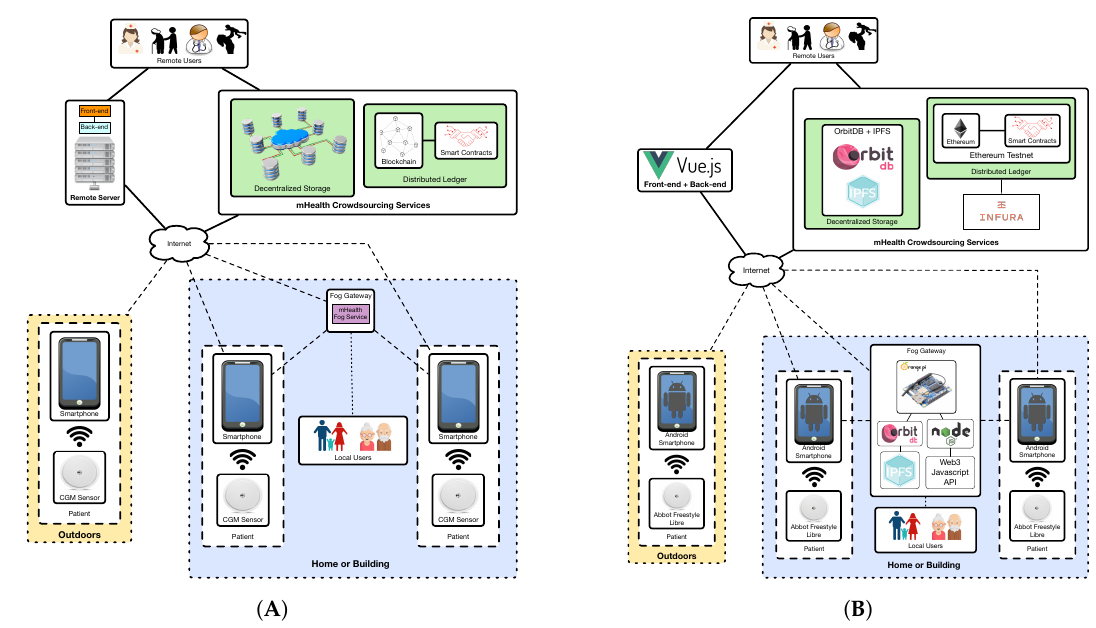
Figure 1. Proposed communications architecture ( A ), and implemented architecture ( B